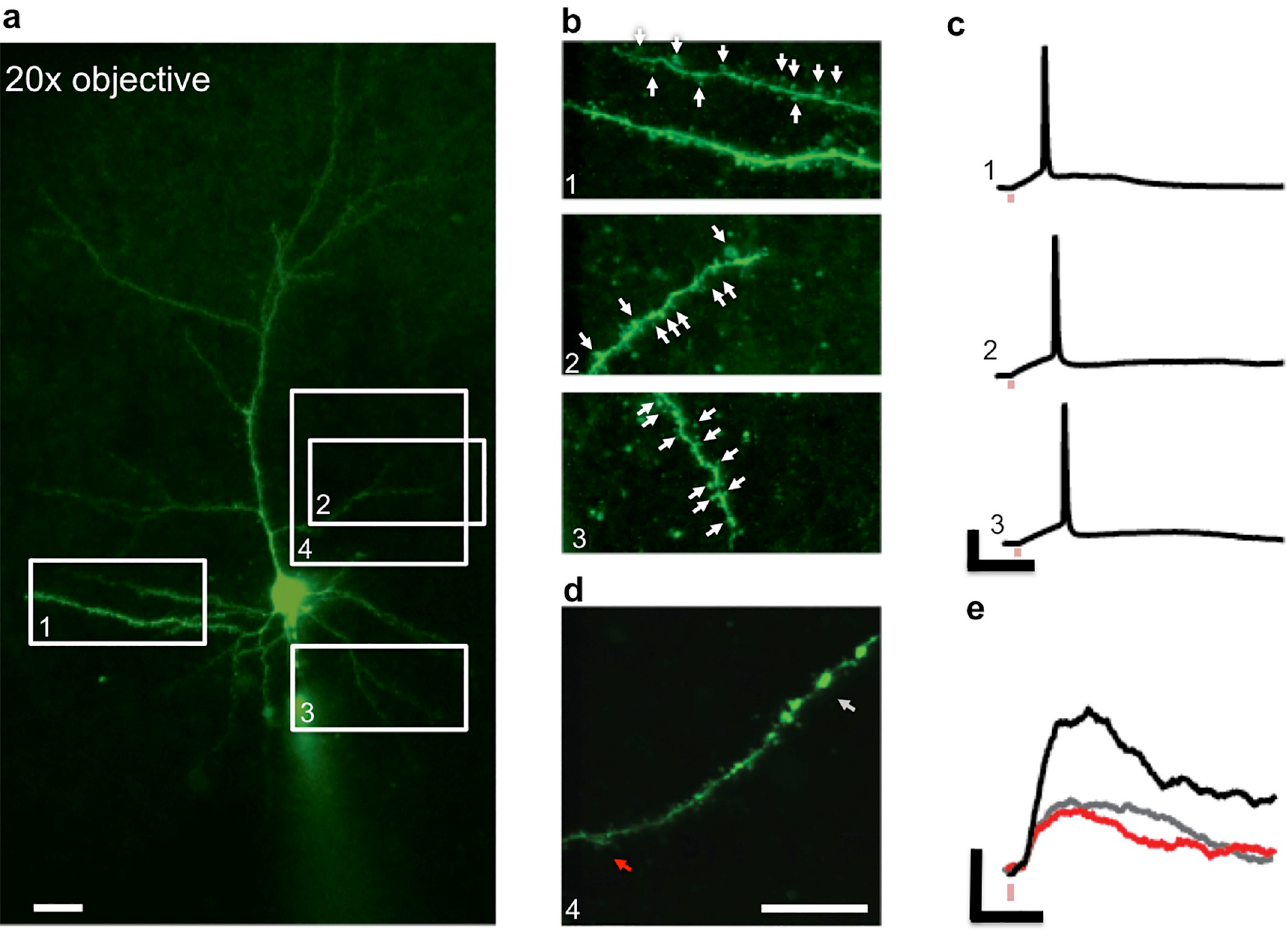
Fig 5. Synaptic integration experiment with a larger VOI. a : Two-photon image of a layer 2/3 pyramidal neuron labeled with OGB-1 using a 20 × objective lens results in a larger FOV. Scale bar: 20 μ m. b : Uncaging VOIs (1, 2 and 3) targeting specific dendrites corresponding to regions indicated in a . Scale bar: 20 μ m. c : Somatic action potentials evoked when simultaneously uncaging at all sites (8-10) within corresponding uncaging VOIs in b . Scale bars: 20 mV, 50 ms. d : Uncaging VOI 4 (region indicated in a ) showing a dendrite that extends 16 μ m along the axial direction. Scale bar: 20 μ m. e : Evoked EPSPs in VOI 4 when two sites are activated separately (red and grey traces) and simultaneously (black trace). Scale bars: 1 mV, 50 ms.